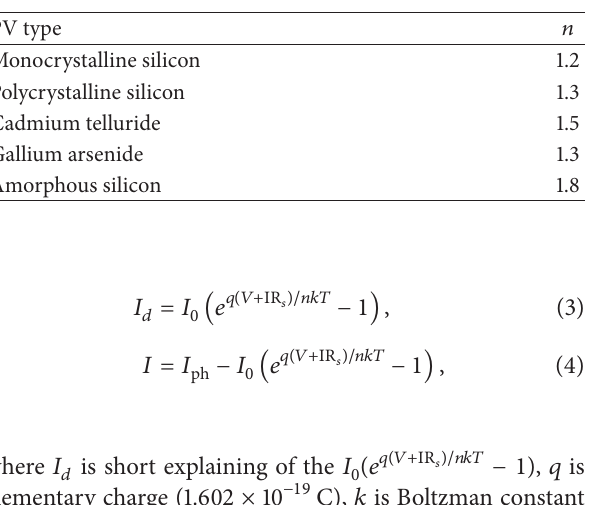
Table 2: Ideality factor of several PV